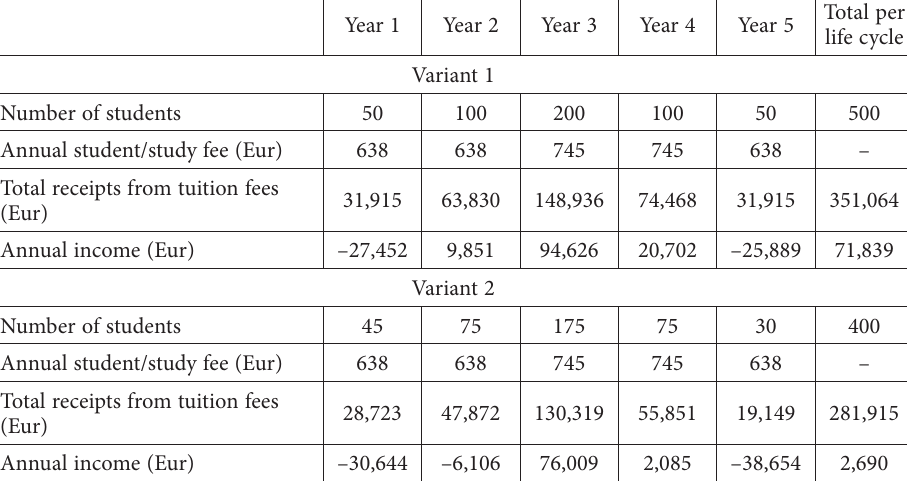
Table 11. One-way analysis by the number of